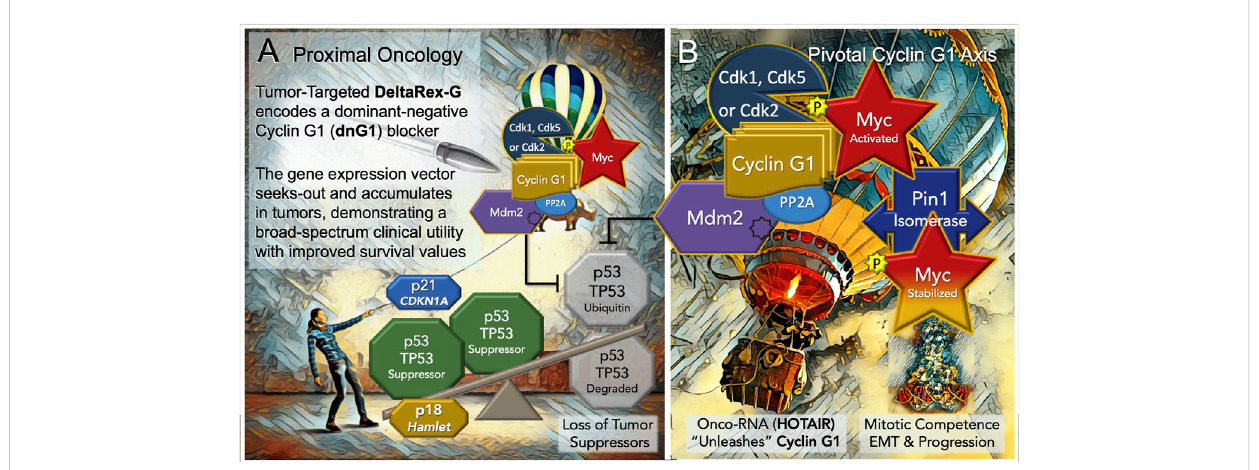
FIGURE 3 Blocking the “ Cyclin G1 Axis ” of Interacting Oncogenes and Tumor Suppressors. (A) DeltaRex-G, encoding a cytocidal ‘ dominant negative ’ , i.e. a truncated construct (dnG1) of the executive cyclin G1 oncogene (CCNG1), is shown as a molecular-genetic “ silver bullet, ” blocking the Pivotal Cyclin G1 Axis of associated oncogenes, which is activated by signal transduction and/or loss of natural tumor suppressors (p53 (TP53); p21, CDKN1A; and p18, Hamlet). (B) The Cyclin G1 Axis of interacting oncoproteins include Cyclin G1, Myc, Cdk2, Cdk5 or Cdk1, Mdm2, and the proline-directed/ phosphorylation-dependent Pin1 isomerase, which stabilizes the Cyclin G1/Cdk-activated Myc oncoprotein by phosphorylation (at serine 62) and maintains its transcriptional bioactivity. Note: loss of the natural tumor suppressors — by 1) mutations in p53, 2) loss of regulatory miRNAs, 3) by viral subversion(e.g.,miR-122),or4)byagrowingnumberofoncogenic-RNAs(e.g.,HOTAIR) —“ unleashes ” theexpressionandfunctionsoftheCyclinG1Axis which lead to stem cell activation, tumorigenesis, error-prone DNA replication, increasing oncogene addictions, EMT/metastasis, and progression of